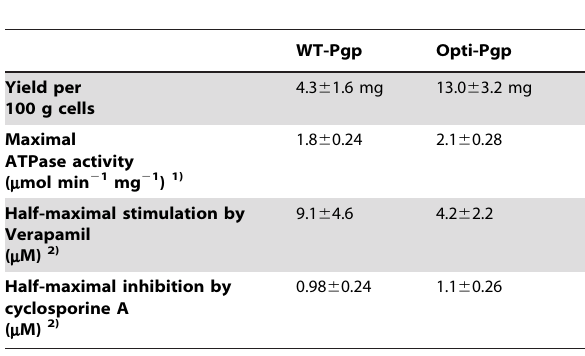
Table 1. Comparison of WT- and